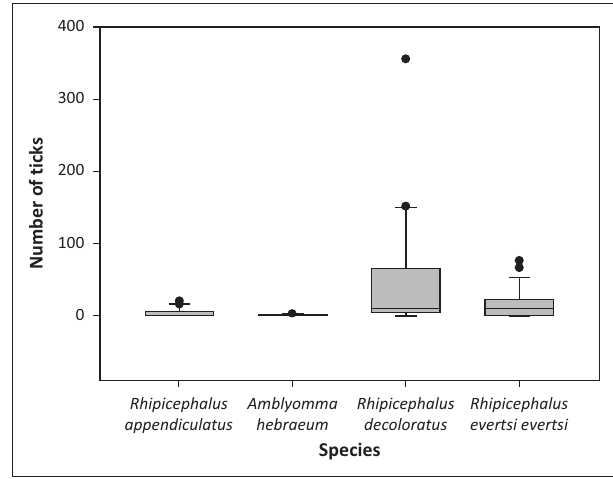
FIGURE 4: Boxplot depicting the significant difference in abundance between individual tick species in the grassland of the sable antelope breeding enclosures on the Farm Hoopdal KQ96. The middle bar, the box and the whiskers refer to the median, the interquartile range and the interoctile (80 % ) range, whilst the dots are extremes or